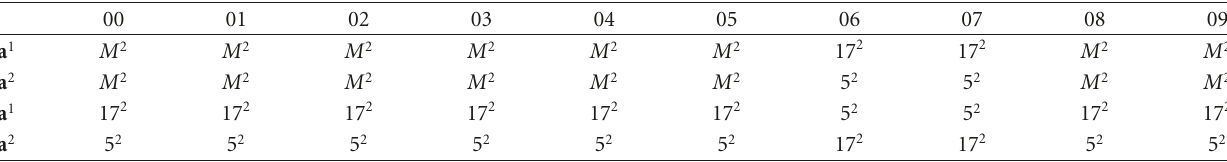
Table 1: Values of the optimal and “nonoptimal” sets a 1 and a 2 for the 20 stripe features. The maximum possible area size is noted M 2 = [ M u × M v